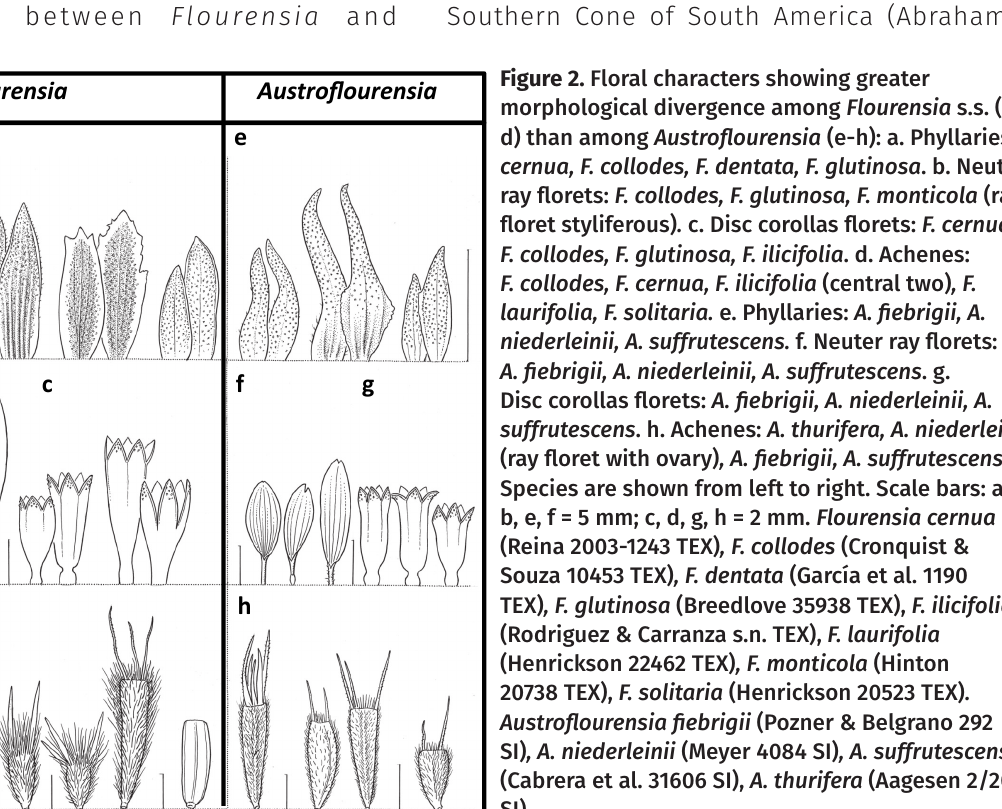
(Cabrera et al. 31606 SI), A. thurifera (Aagesen 2/2015